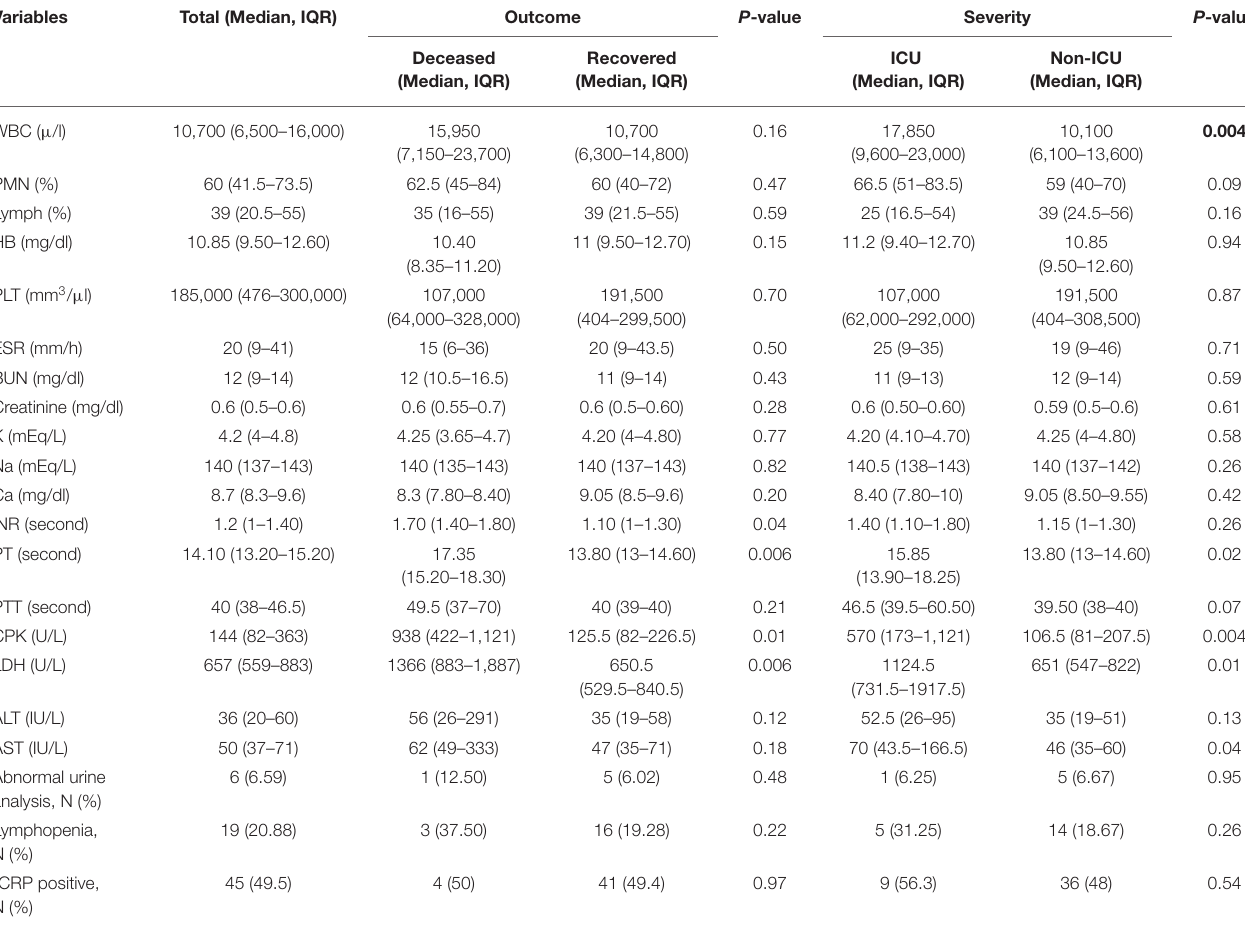
TABLE 3 | Laboratory data of pediatric COVID-19